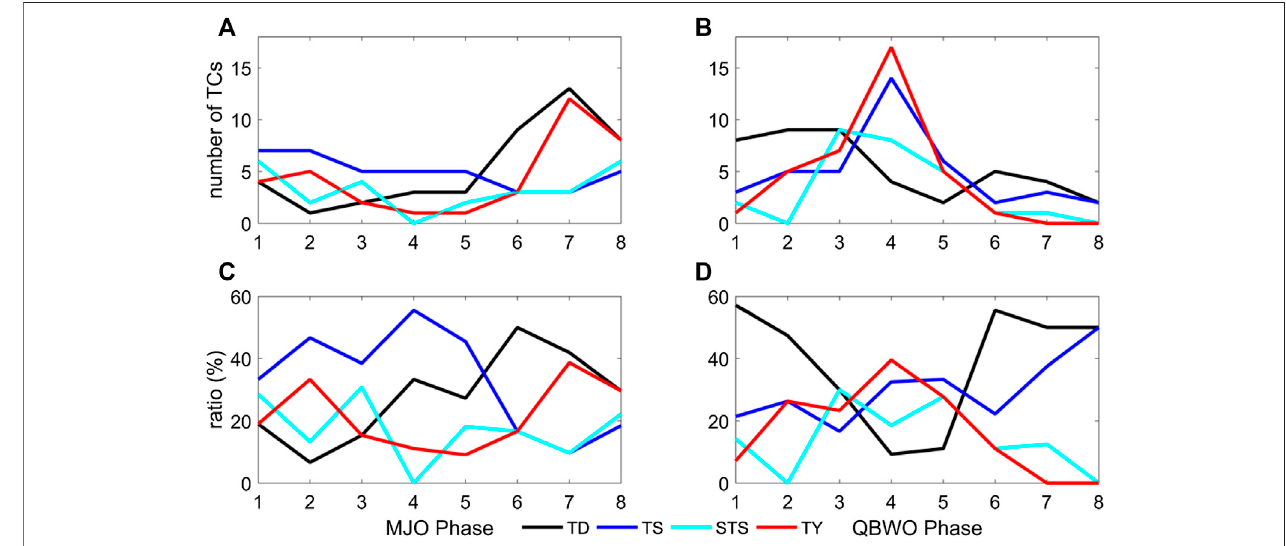
FIGURE 8 | The number (A , B) and ratio (C , D) of nonlocal TCs of each intensity category in each phase of MJO (A , C) and QBWO (B , D) .